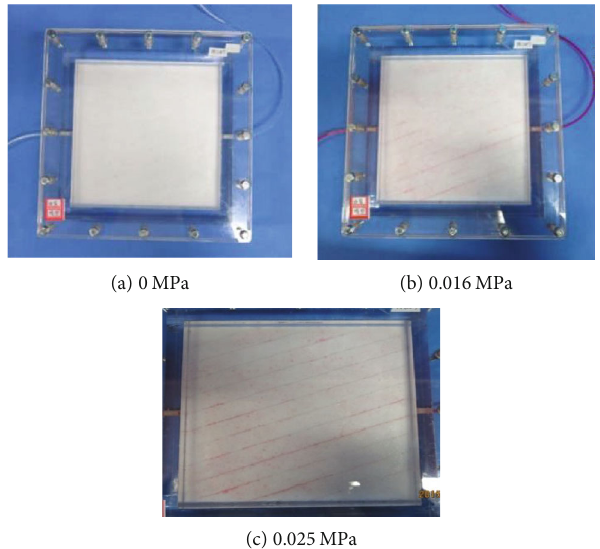
Figure 7: Fracture aperture as a function of average pore- fl uid